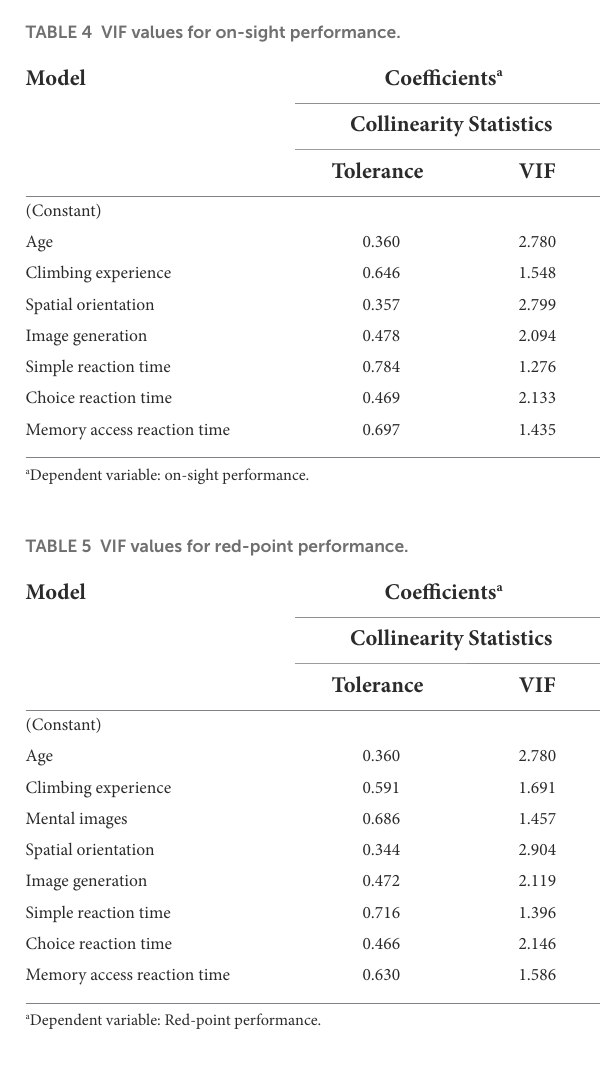
TABLE 6 Model summary for predicting on-sight performance.